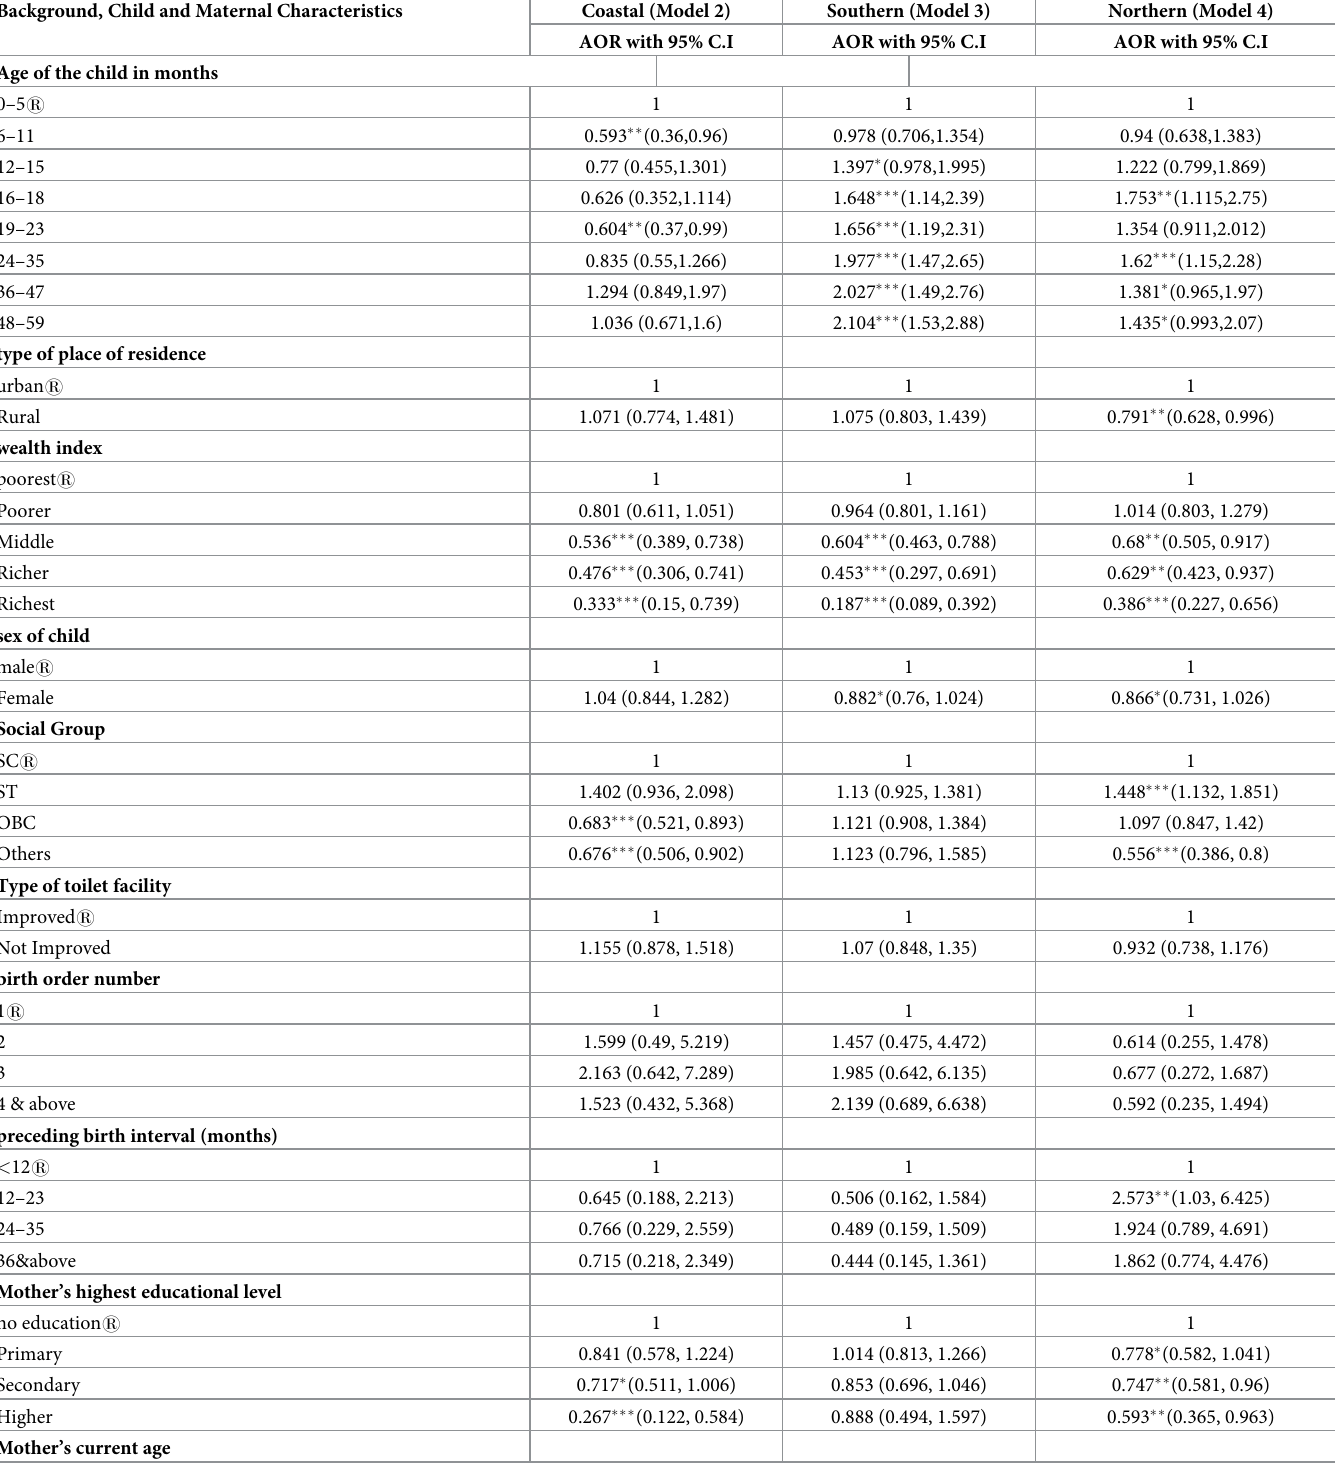
Table 5. Impact of the background, child and maternal characteristics, on the child underweight as per the Odisha NSSO natural-regions, assessed by adjusted logistic regression, NFHS-4 (2015–16). Background, Child and Maternal